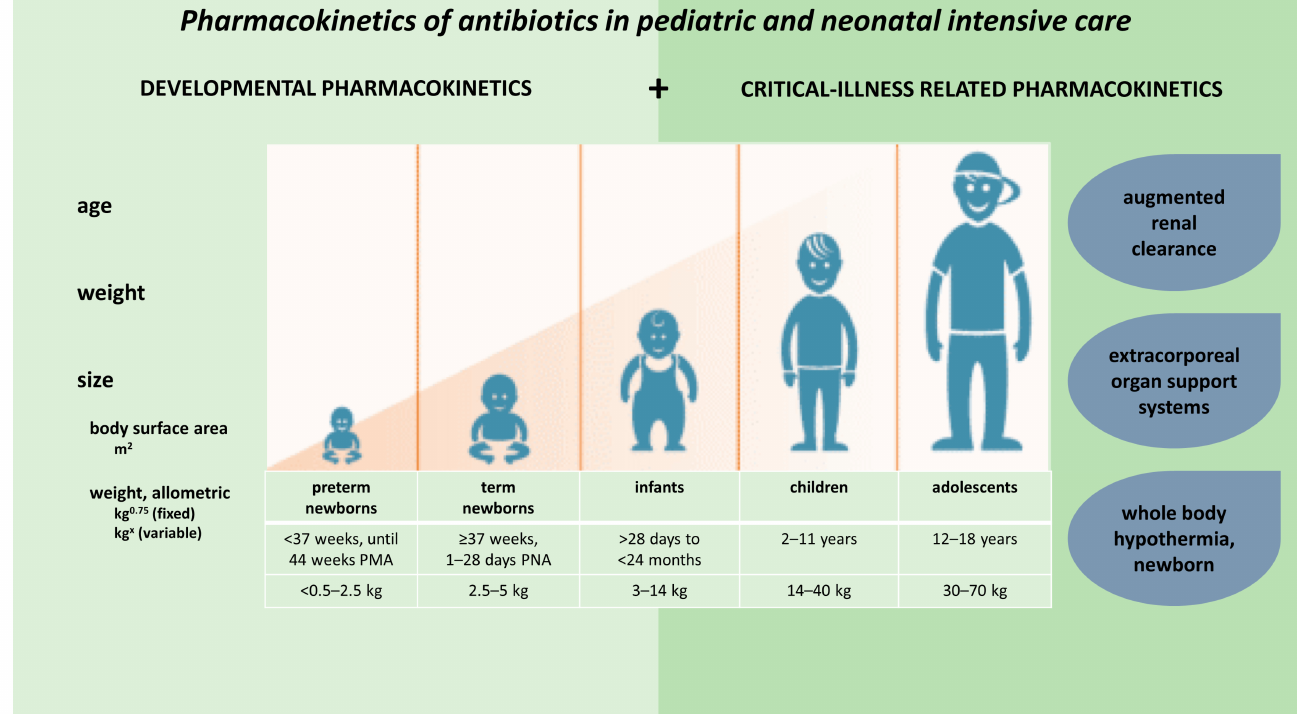
Figure 1. Illustration of developmental and critical-illness related pharmacokinetic alterations in children and